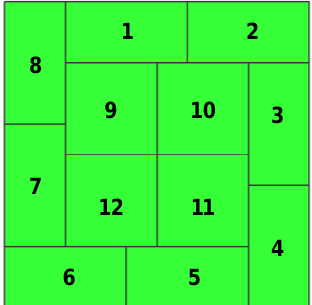
Figure 3. The dummy pattern configurations of the bottom view for the genetic algorithm in the case of Figure 2.